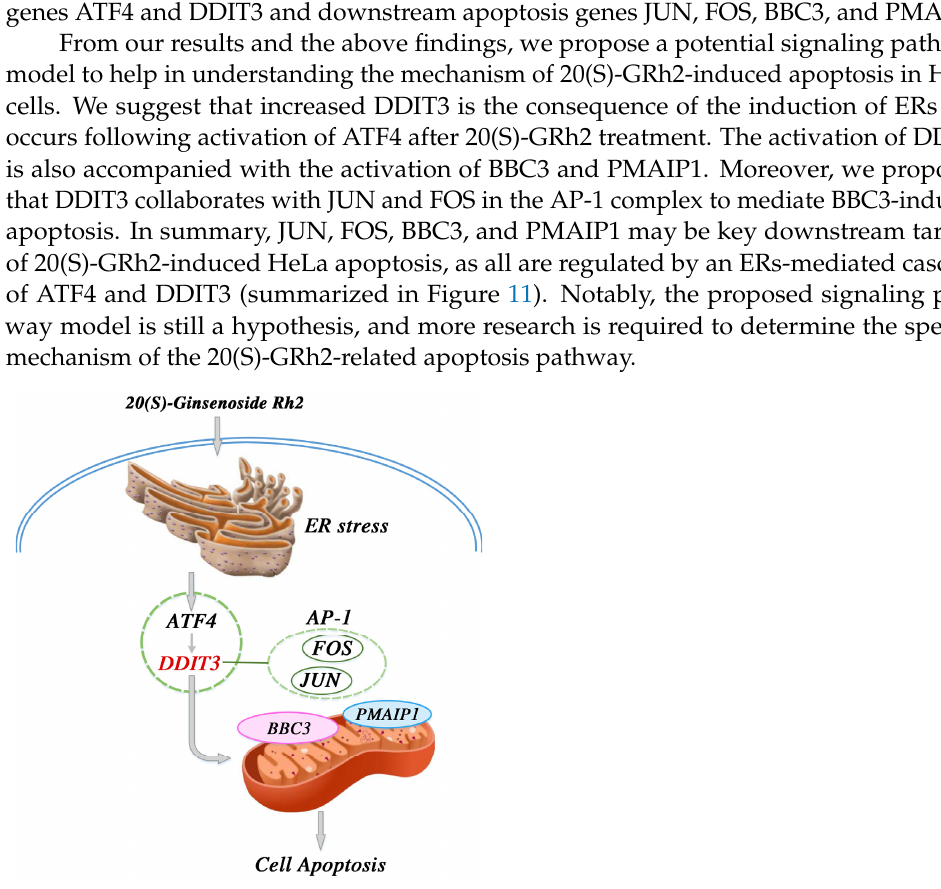
Figure 11. Proposed signal pathway for the anticervical cancer mechanism of 20(S)-GRh2. 20(S)-GRh2, 20(S)-ginsenoside Rh2.